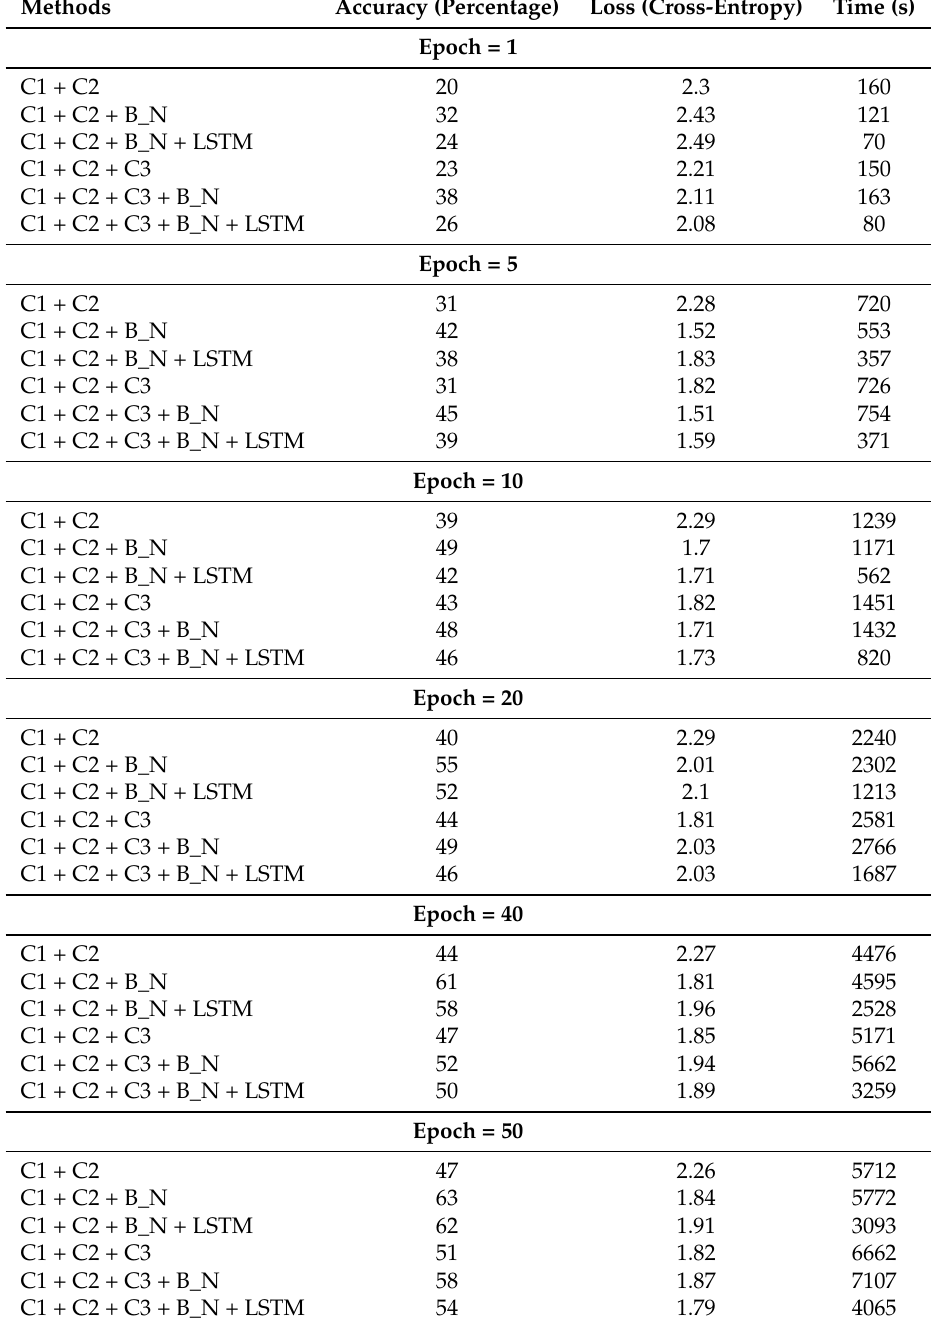
Table 6. Accuracy, loss and time for different numbers of epochs (10% sample) for the CIFAR10dataset.